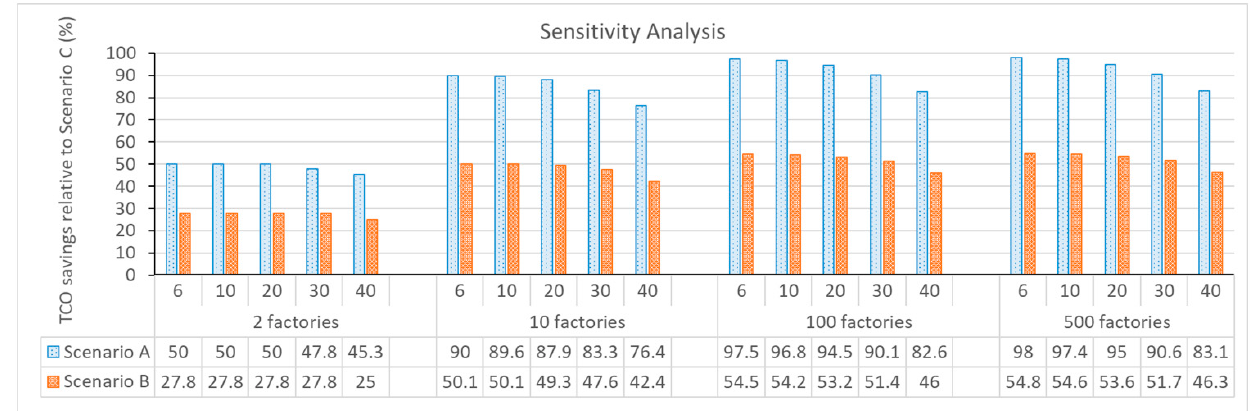
Figure 11. Sensitivity analysis—TCO savings in scenario A and B over scenario C, by varying the growth of devices and number of factories.